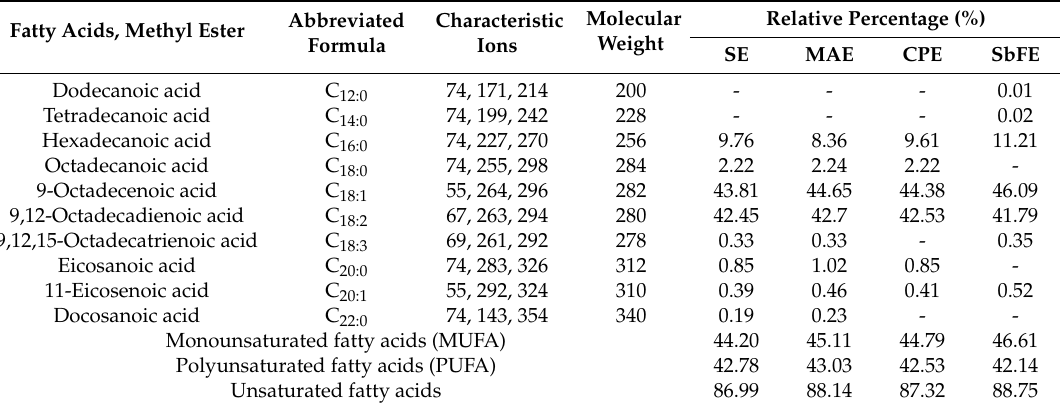
Table 4. Fatty acid composition and their relative percentages in C. sinensis seed oil as extracted by the four different